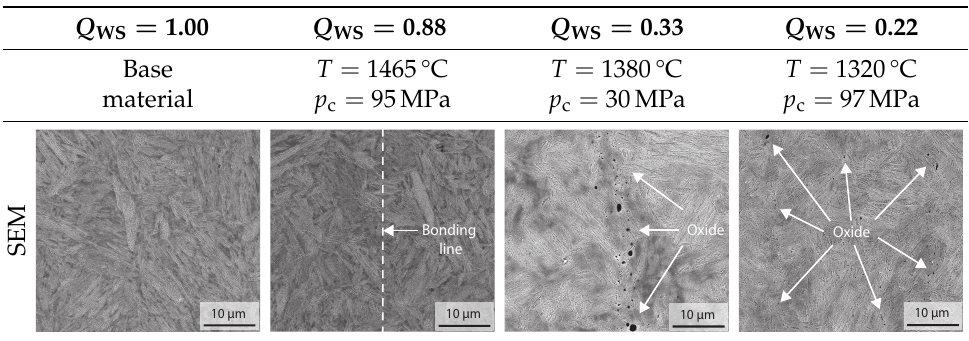
Table 7. Comparison of SEM images of the hardened base material and the bonding line of hardened 34MnB5 steel sheets welded with different welding parameters ( T , p c ) and different weld seam strength ratios Q WS .